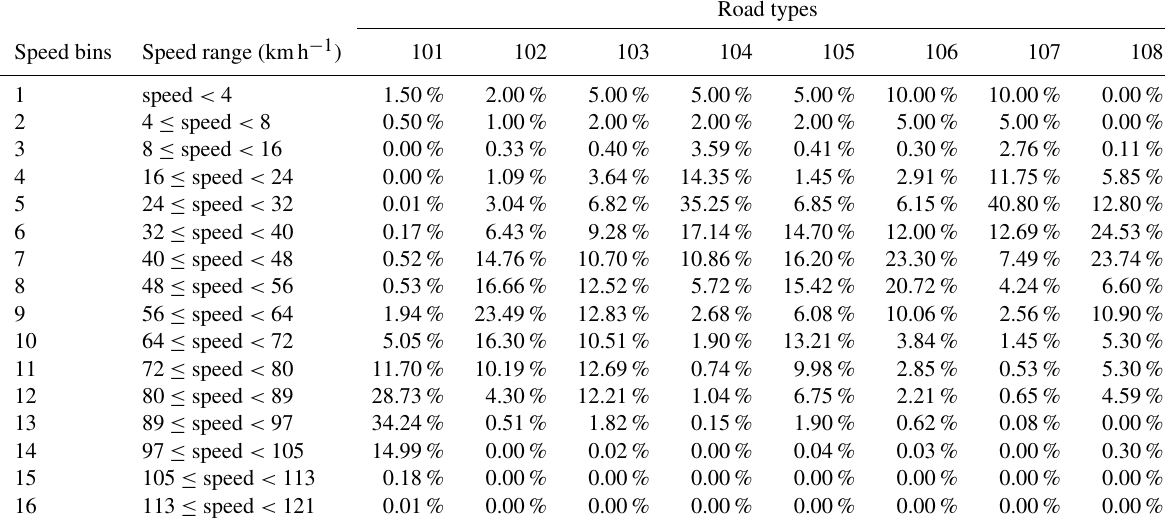
Table E1. Average speed distribution (ASD) for each road type. The table columns are different road types, and the table rows are speed ranges of each speed